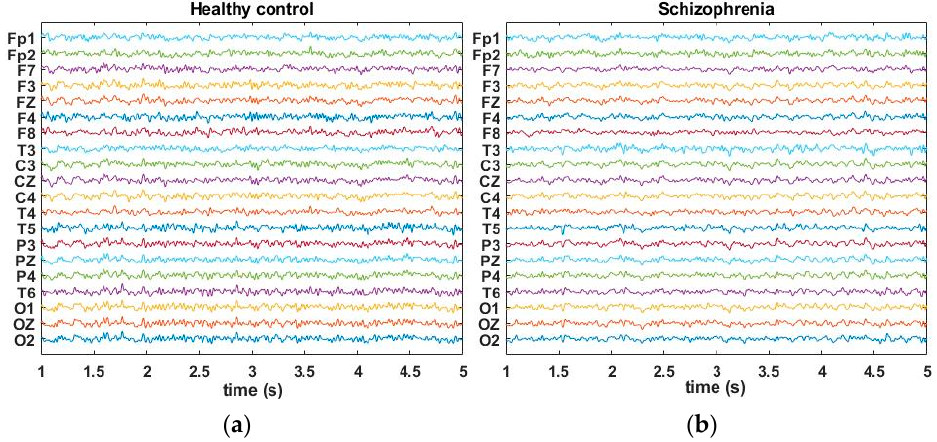
Figure 1. EEg signals of ( a ) a healthy control and ( b ) a schizophrenic patient.